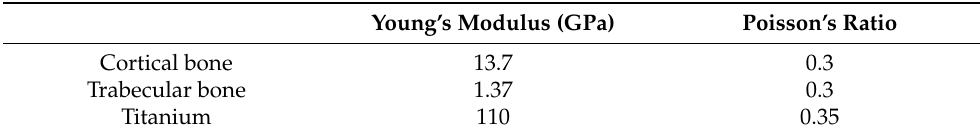
Figure 1. Finite element models for the alveolar bone and an orthodontic miniscrew were constructed: ( a ) An orthodontic miniscrew was implanted into the alveolar bone in the finite element model. Total length of the thread part of the orthodontic miniscrew was set at 6 mm and the top of the thread was completely placed into cortical bone; ( b ) A magnified image of the contacted interface of bone and the surface of orthodontic miniscrew. The condition of contact was set up as surface to surface contact with an algorithm of the argumented Lagrangian method and the coefficient of friction was set at 0.3. Table 1. The material properties used for finite element